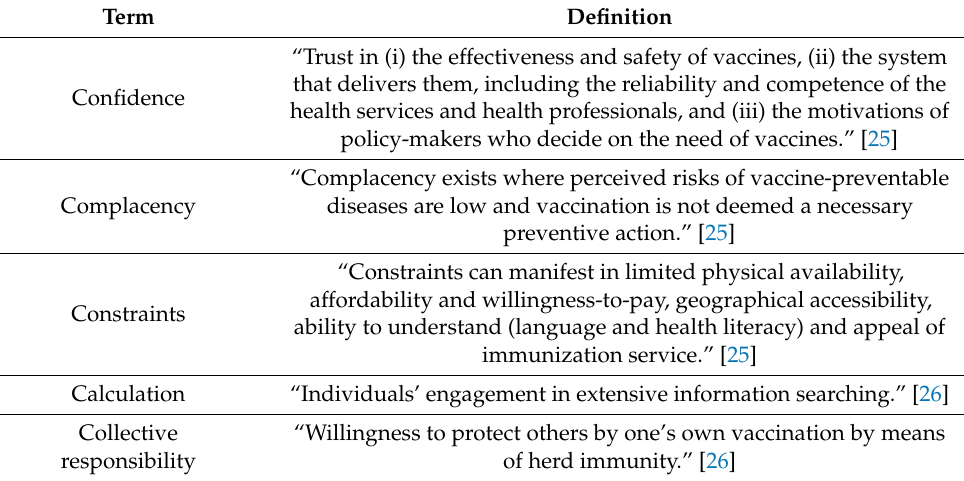
Table 1. 5C Psychological Antecedents